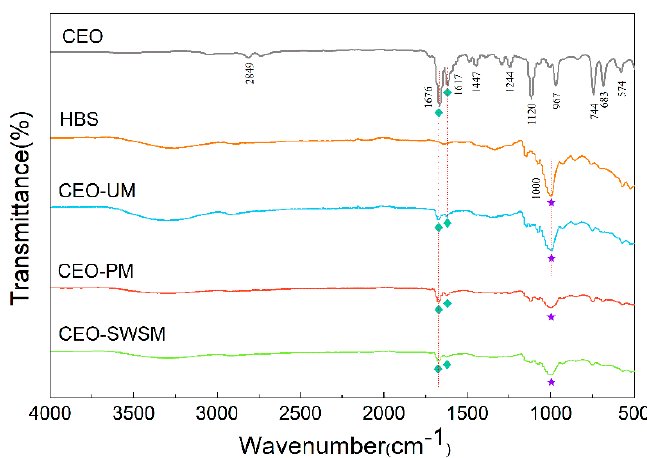
Figure 2. FT-IR spectra of CEO, HBS, and the CEO-SWSM, CEO-PM, and CEO-UM microcapsules.